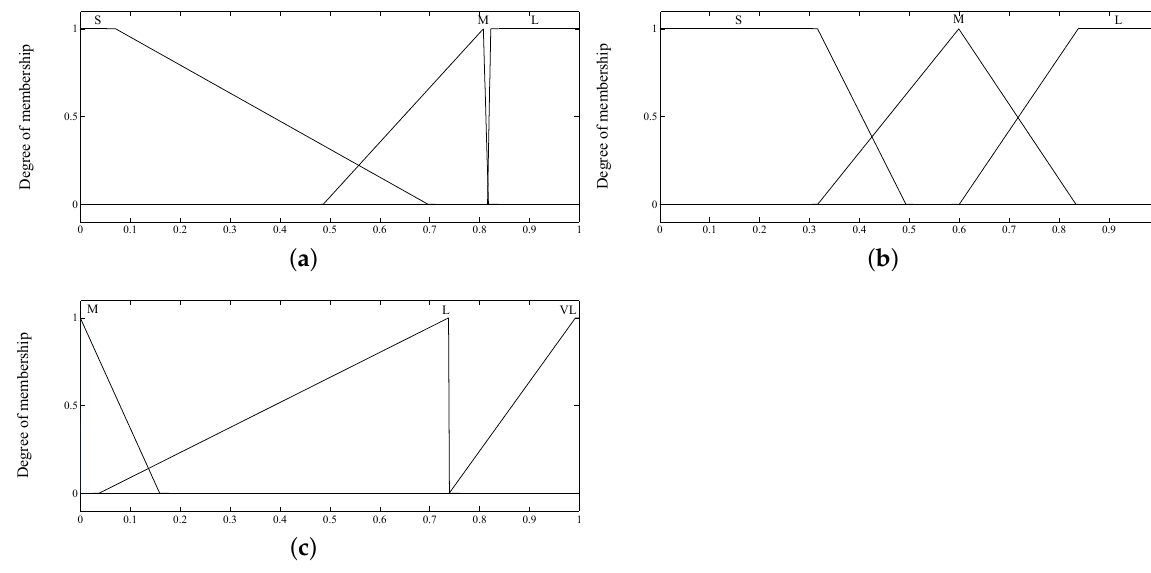
Figure 9. Optimized fuzzy sets of the moderator’s FIS. ( a ) Membership functions for input Q s ; ( b ) Membership functions for input Q m ; ( c ) Membership functions for output α .